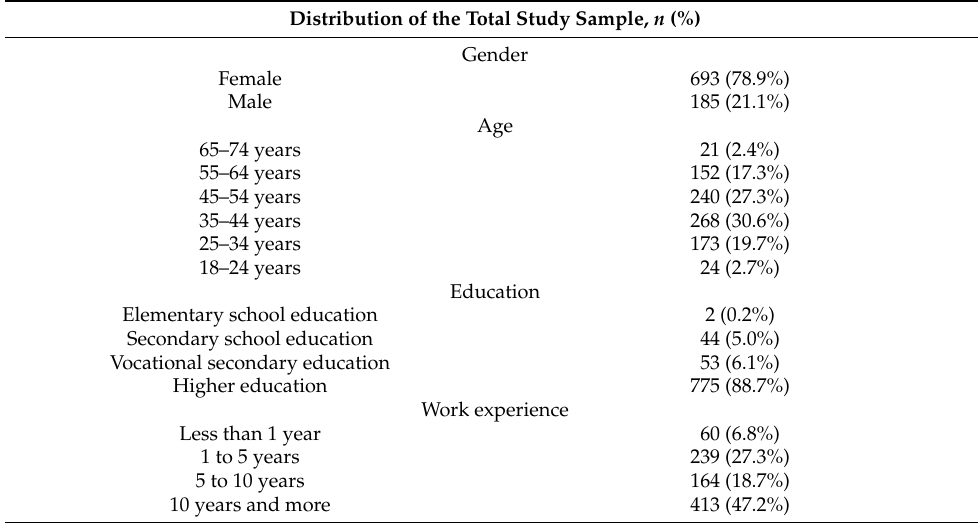
Table A1. Socio-demographic characteristics of the web-survey study sample included in the analysis for the preventive measures taken by the